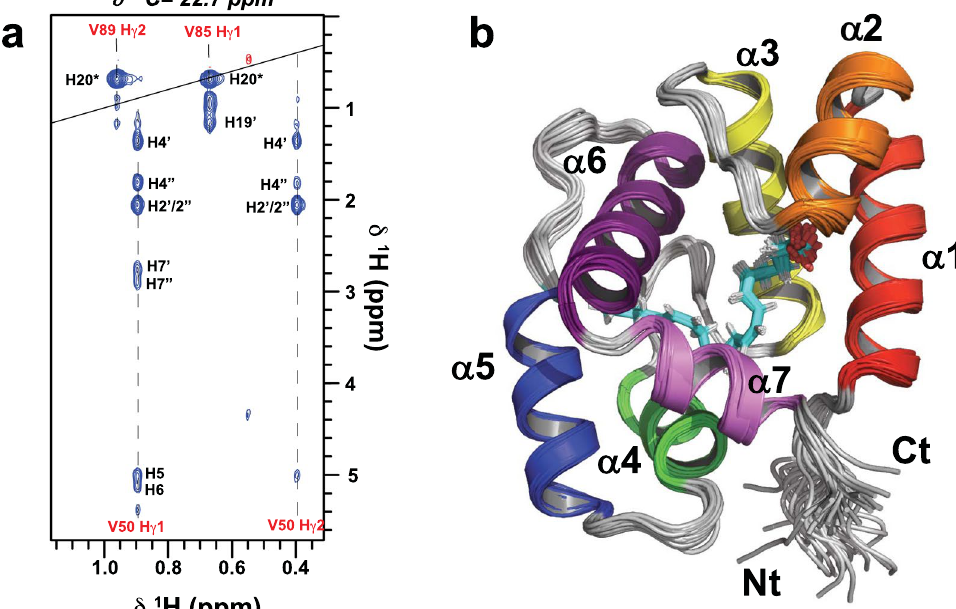
Figure 4. NMR Structure of the AeOBP22-AA Complex (a) A slice through a 12 C-edited/ 13 C-filtered intermolecular NOESY spectrum at δ 13 C = 22.7 ppm showing NOEs between resonances from the protein (labeled in red) and arachidonic acid (black labels). For the lipid the hydrogens are numbered according to the attached carbon in the alkyl chain. (b) Superposition of the 30 lowest energy structures from the final iteration of NMR calculations (RMSD = 0.32 Å for res 7–121), helices 1–7 are color coded from red-violet. The arachidonic acid is shown in